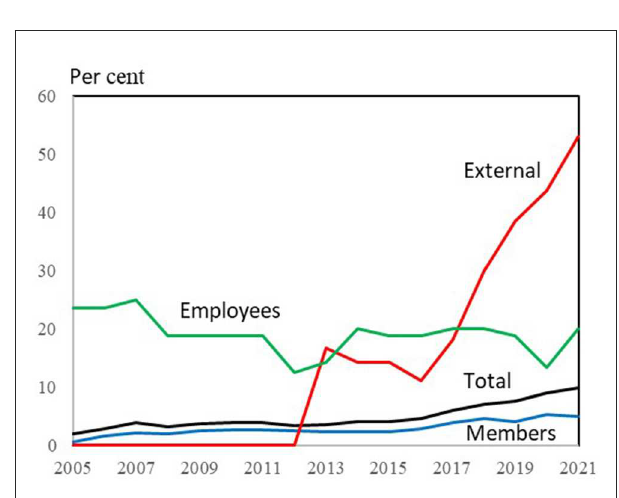
Cooperative members are elected in accordance with the statutes among the active members of the cooperative. Typically farmers, or managers on larger farms, can vote and can be elected. Each farmer or farm has one vote.